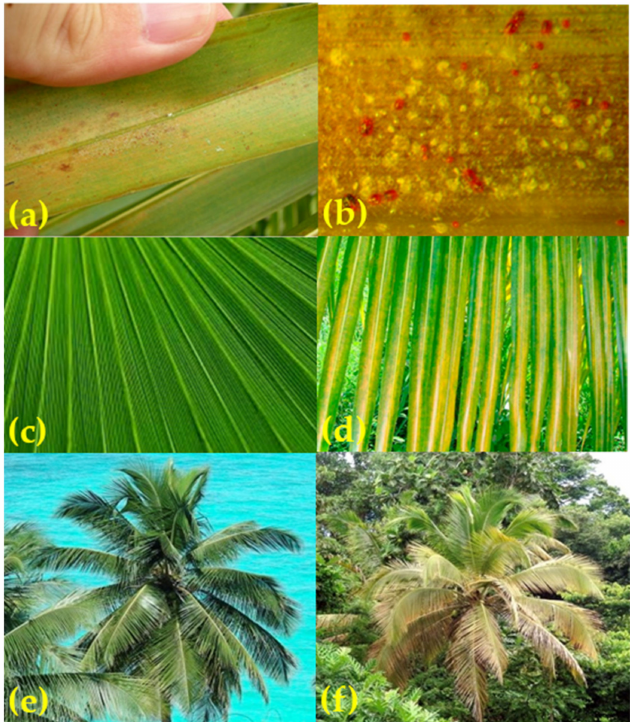
Figure 2. E ff ects of RPM on coconut palms. ( a ) Infestation on abaxial surface; ( b ) magnified abaxial surface showing damage; ( c ) healthy pinnae; ( d ) chlorotic pinnae; ( e ) healthy palm; ( f ) RPM-damaged